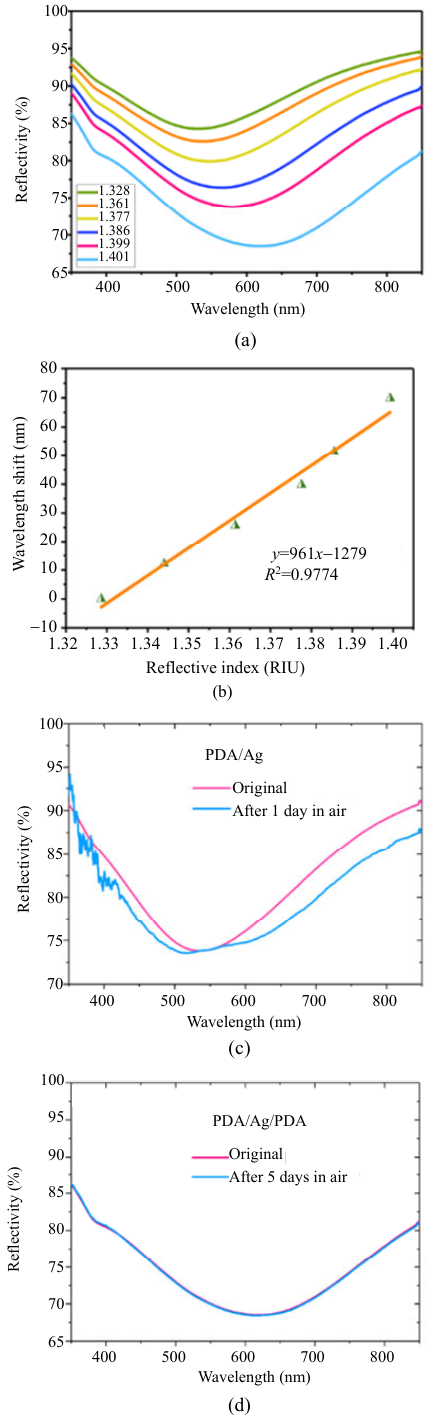
Fig. 4 LSPR performance and stability of PDA/Ag/PDA optical fiber sensor: (a) the reflective spectra of the PDA/Ag/PDA-based LSPR sensors in different alcoholic solutions, (b) changes in the LSPR wavelength shift of the as-prepared sensors to the RI, (c) reflectivity spectra of the PDA/Ag-based LSPR sensor, (c) PDA/Ag/PDA-based LSPR sensor and (d) in butanol before treatment and after storage in the